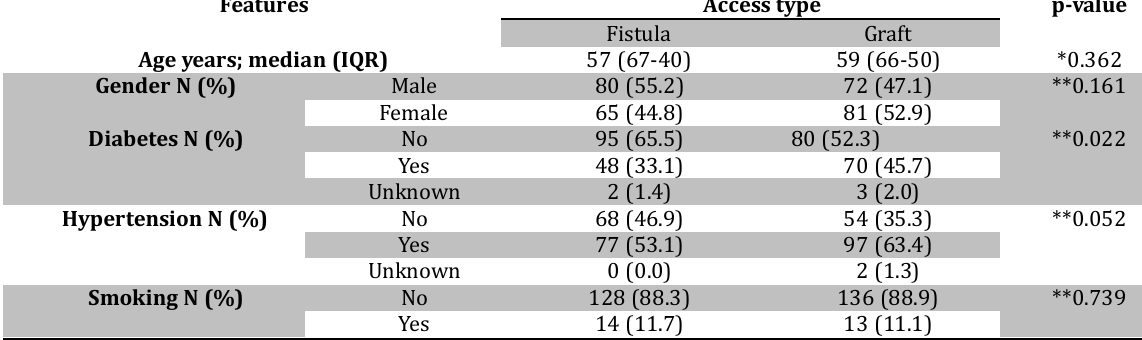
Table 2 .Comparing age, gender, underlying disease, and smoking between two different access